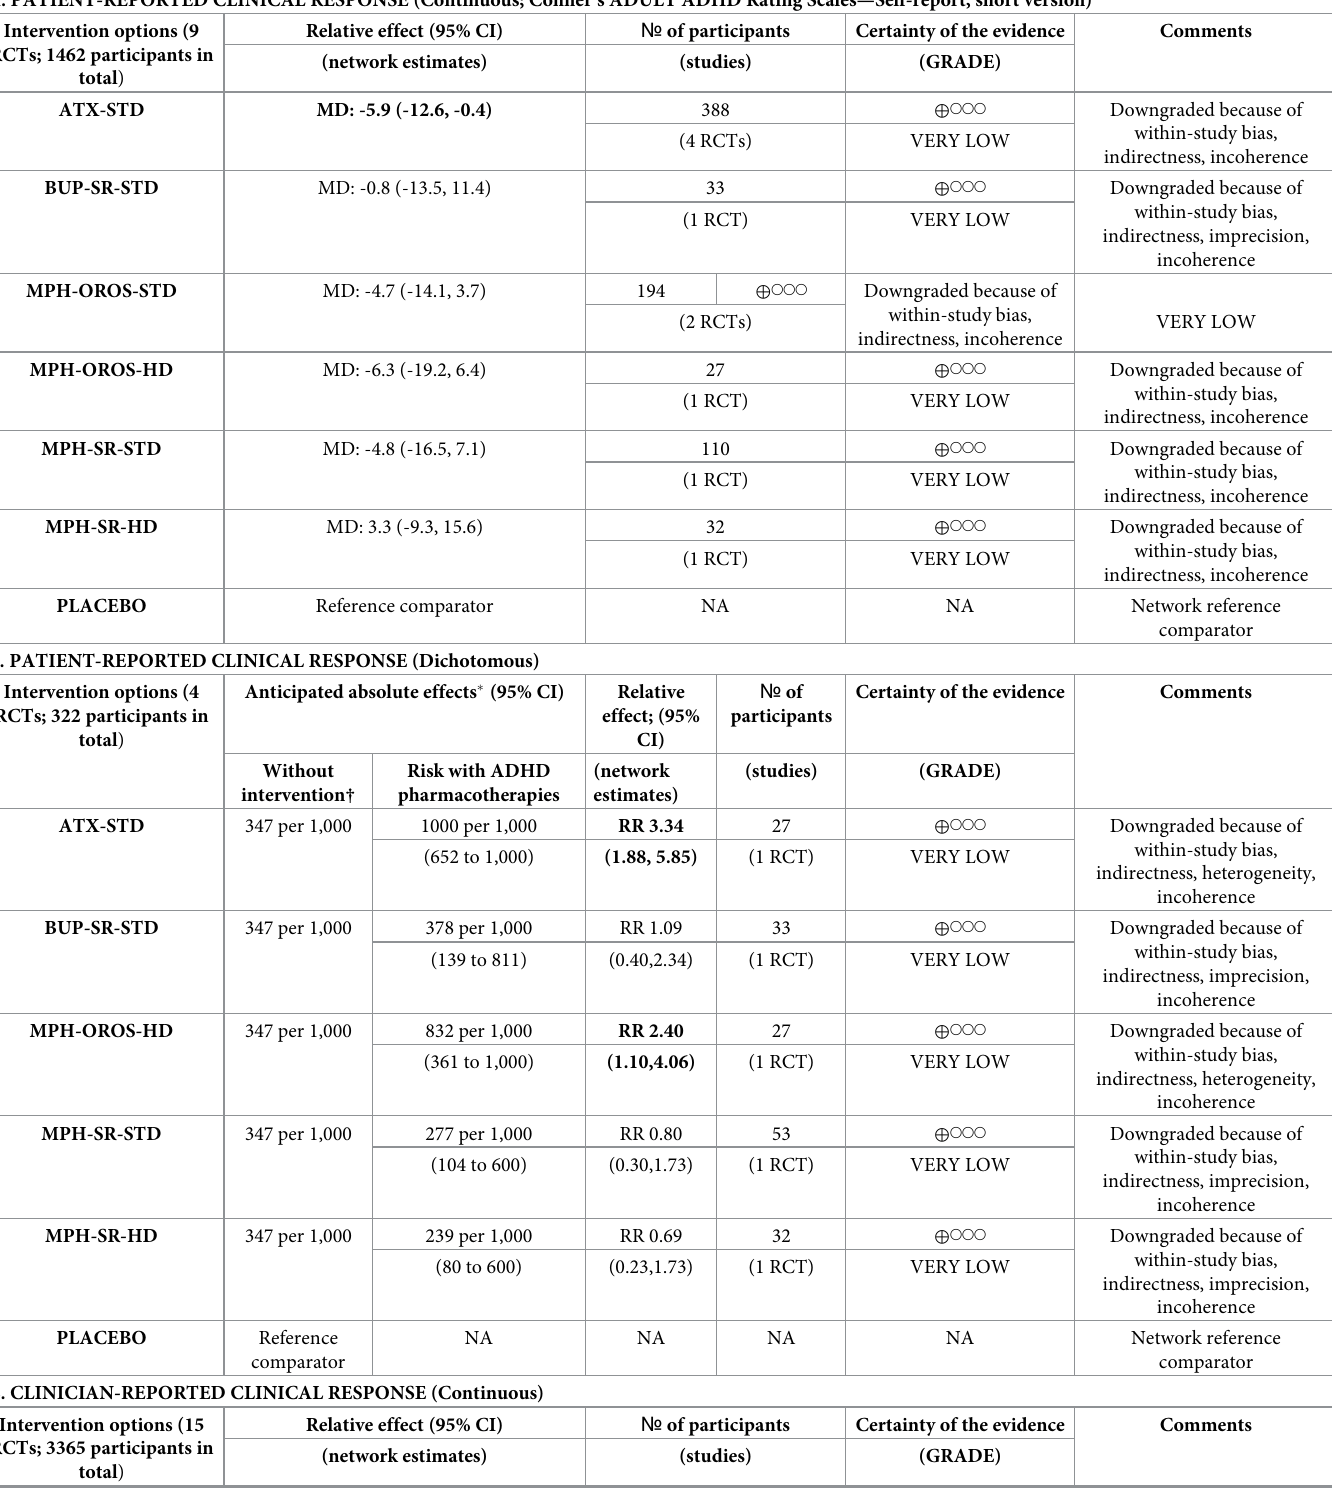
Table 3. Summary of